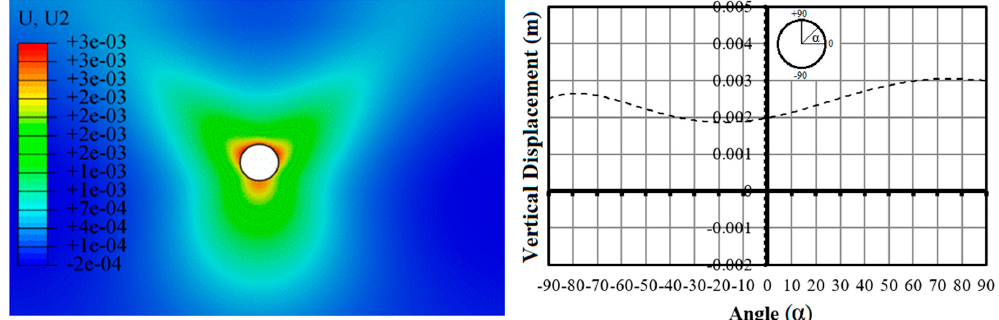
Figure 14. Displacements in the vertical direction under transient flow conditions.